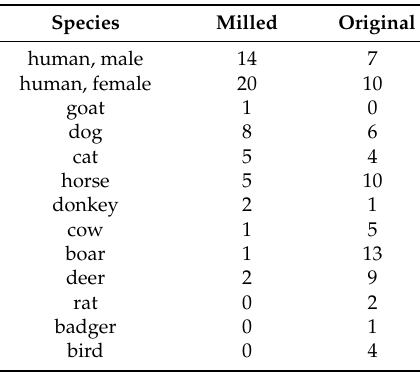
Table 2. List of 131 reference